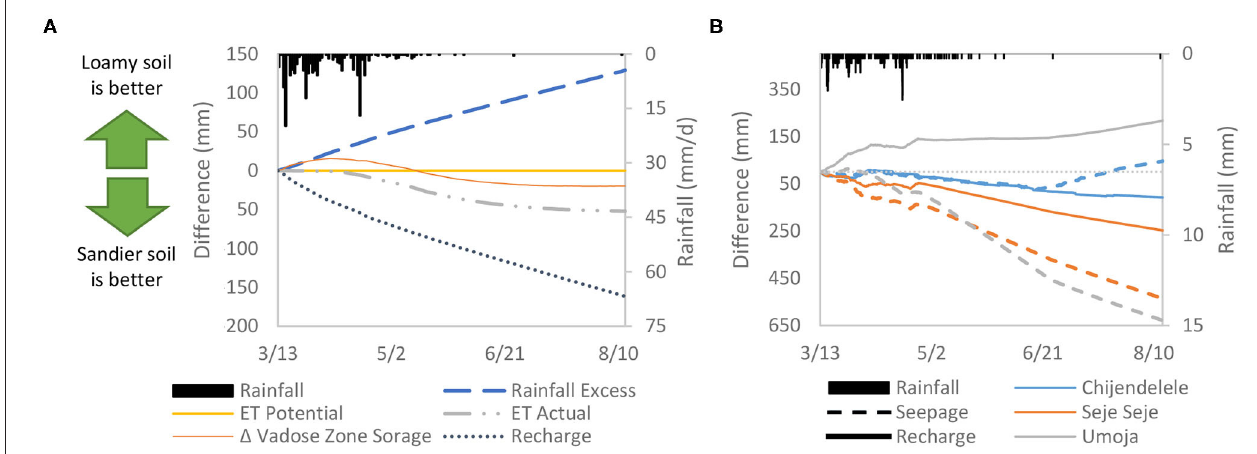
FIGURE 9 | (A) Comparative trends in aggregate overland flow quantities for the Chididimo watershed after increasing the sand fraction. (B) Comparative trends in groundwater flow parameters for each of the three sand dams after increasing sand fraction. For both (A,B) , a quantity above the y = 0 line indicates that S1 (loam) produced values more beneficial to water storage in sand dams than S4 (sandy clay loam). The converse also applies with quantities below the y = 0 line indicating S4 is more beneficial.